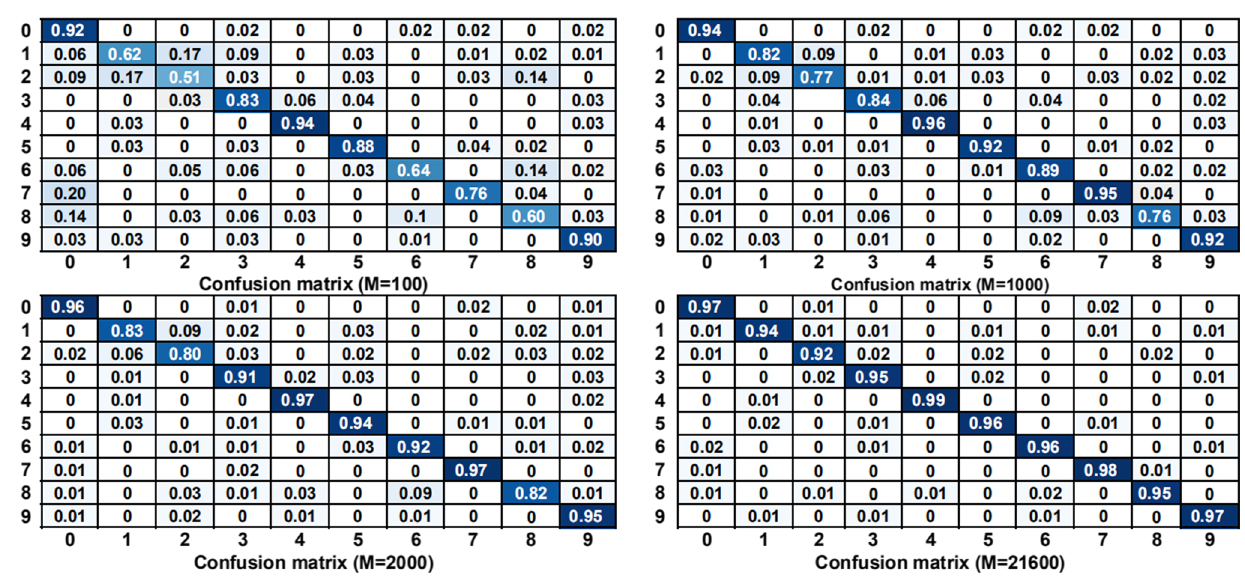
Table 2 The comparison results accuracyMethods The labeled sample number on EuroSAT The labeled sample number on UC of ablation study